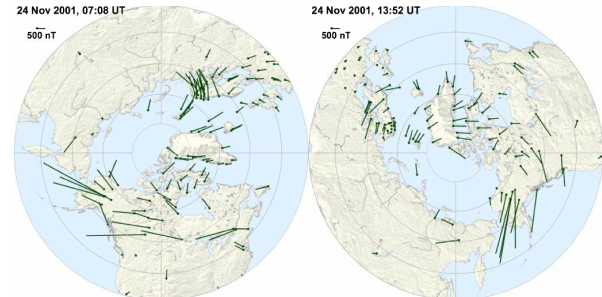
Figure 3. Polar images during two SSS events shown in Fig. 2. The green lines show the magnetic perturbations over the North- ern Hemisphere during the two SSS events. These are taken from the SuperMAG data sets from individual ground magnetometer sta- tions.